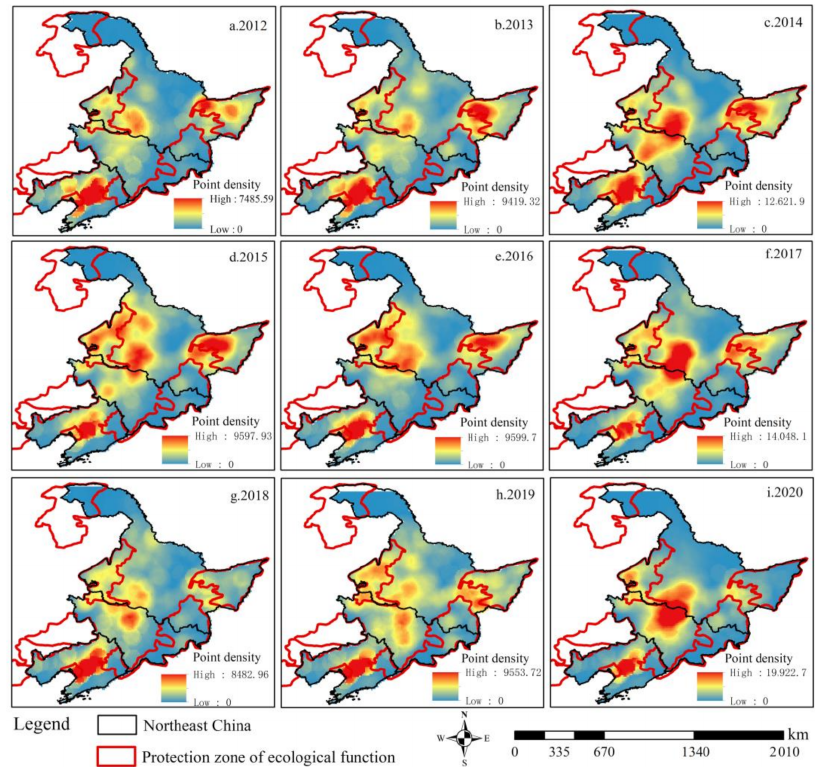
Figure 3. Annual point density of active fires in Northeast China from 2012 to 2020.